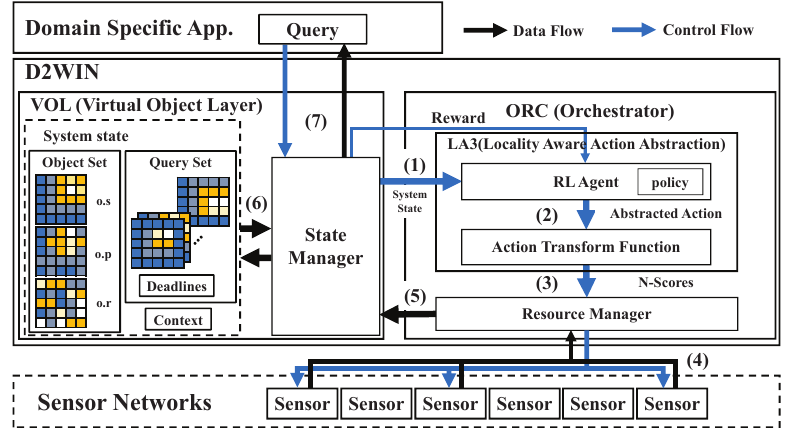
Figure 4. Framework architecture: The RL-driven multistage tasks (1–7) used to schedule the jobs for updating objects are described with the respective numbers on the control and data